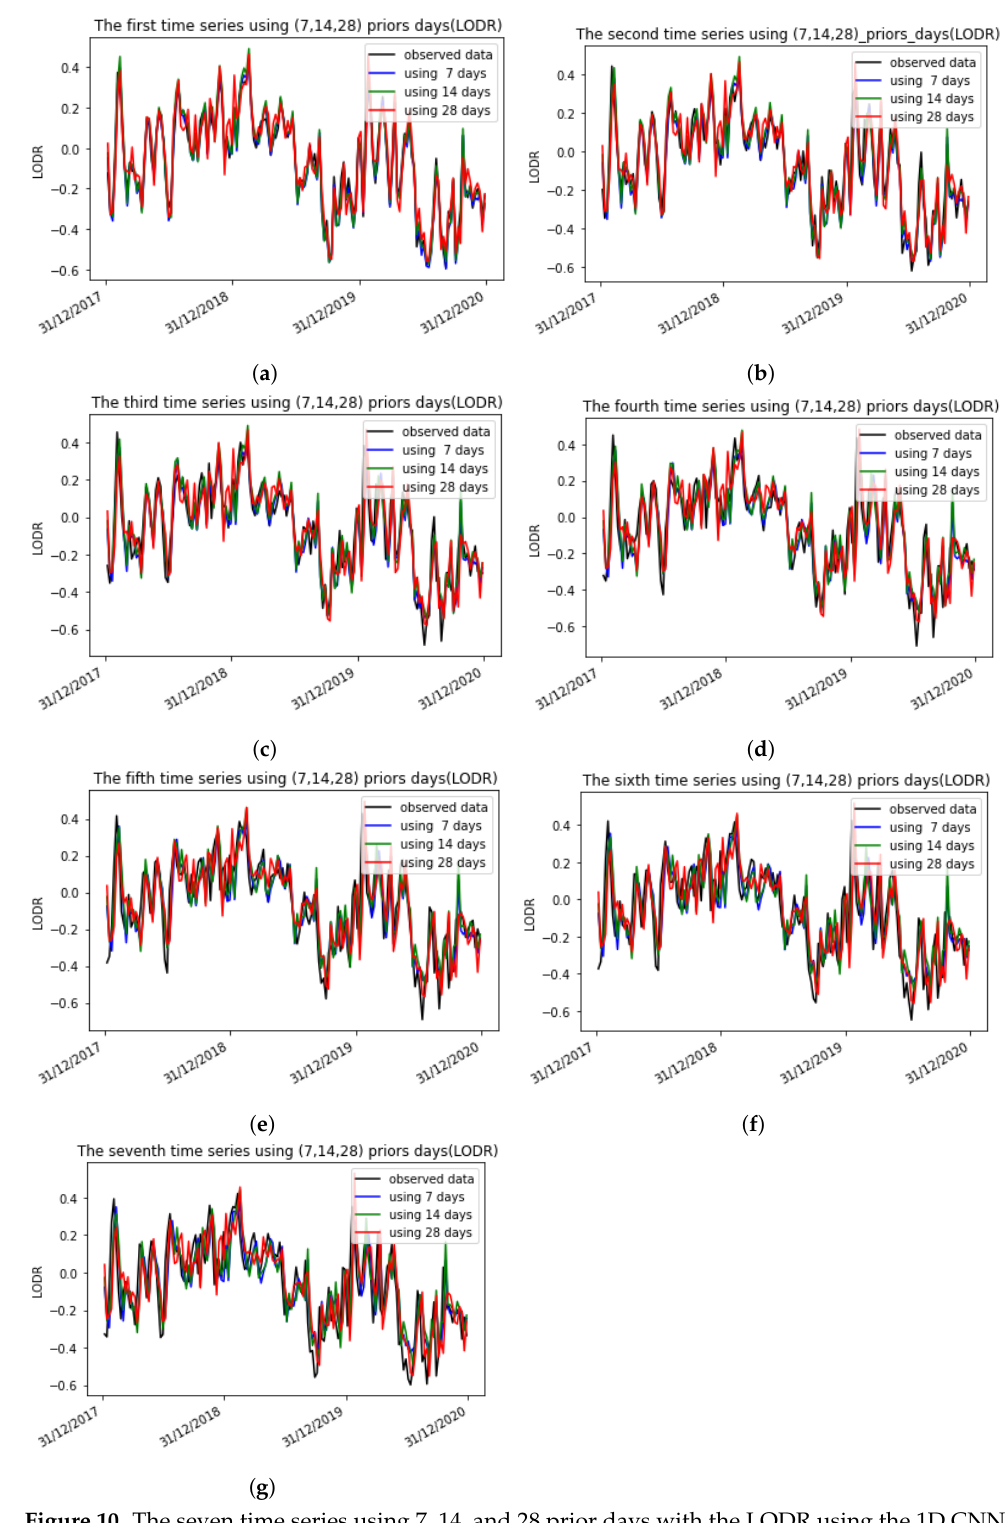
Figure 10. The seven time series using 7, 14, and 28 prior days with the LODR using the 1D CNN. Each plot represents, respectively, the first and the second to the seventh prediction days using different input sizes. The number of predicted weeks covers 3 years (2017, 2018, 2019). ( a ) The first time series using 7, 14, 28 prior days (LODR); ( b ) The second time series using 7, 14, 28 prior days (LODR); ( c ) The third time series using 7, 14, 28 prior days (LODR); ( d ) The fourth time series using 7, 14, 28 prior days (LODR) ( e ) The fifth time series using 7, 14, 28 prior days (LODR); ( f ) The sixth time series using 7, 14, 28 prior days (LODR); ( g ) The seventh time series using 7, 14, 28 prior days